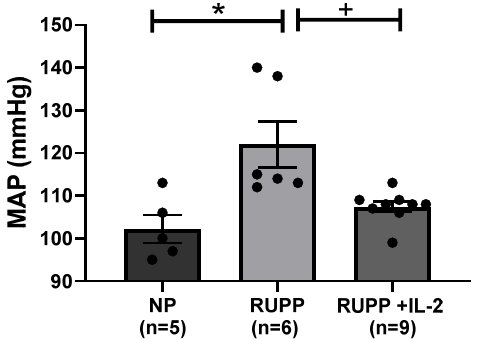
Figure 1. Mean arterial pressure was elevated in RUPP rats ( n = 6) compared to NP rats ( n = 5), but was normalized in RUPP rats administered a lose dose of IL-2 ( n = 9). Results were reported as means ± SEM and considered statistically significant when p < 0.05. (* p < 0.05 vs. NP control; + p < 0.05 vs. RUPP). Table 1. Placental Weights, Fetal Weights, Percent of Total Reabsorptions, and Percent Survival.